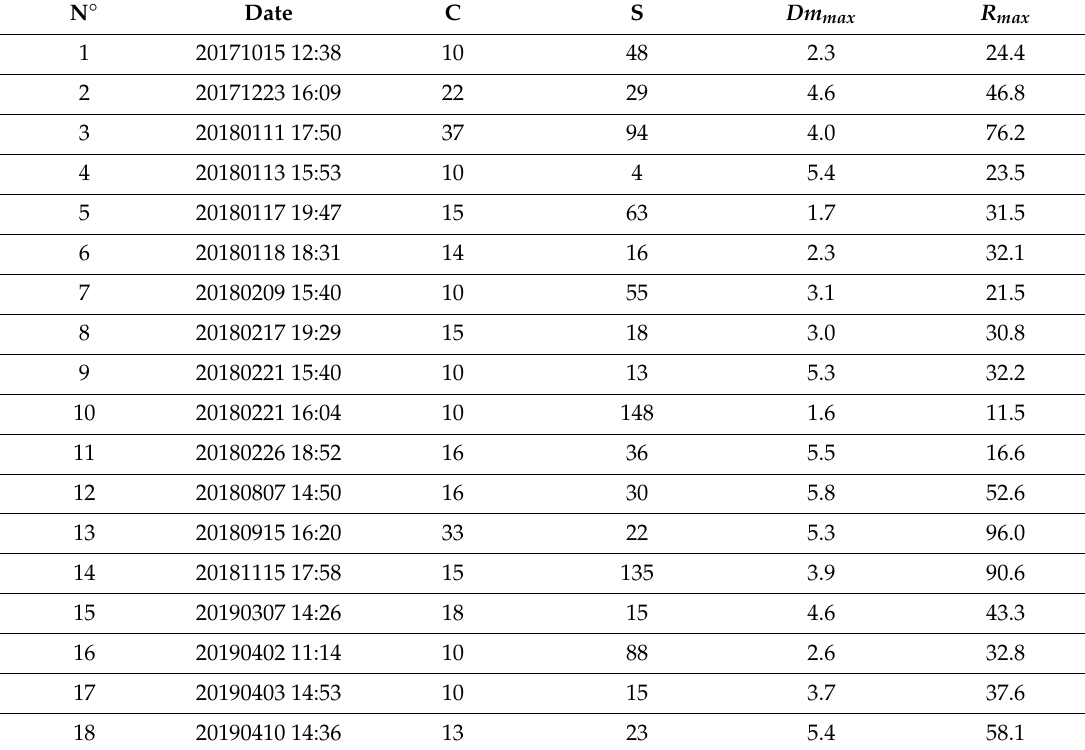
Table 3. Date and time of occurrence of the rainfall events containing at least 10 min of convective rainfall in a sample of 18 months, between 2017 and 2019 with Parsivel2 records. S is the time (minutes) duration of the stratiform rainfall in every event and C is the time (minutes) duration of the convective rainfall in every event. Dm max is the maximum diameter (mm) and R max is the maximum rain rate (mm / h) of the rainfall